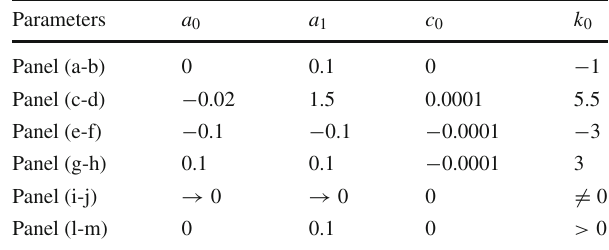
Fig. 3 Orbit collection of different types in axial symmetric galaxy model for different possible values of the parameters. The upper and middle panels refers to the composition of MWpotential2014 and Weyl potentials. The red dot signs the globular cluster Omega Centauri’s orbit Table 1 The defined values of parameters ( a 0 , a 1 , c 0 , k 0 ) used in galpy